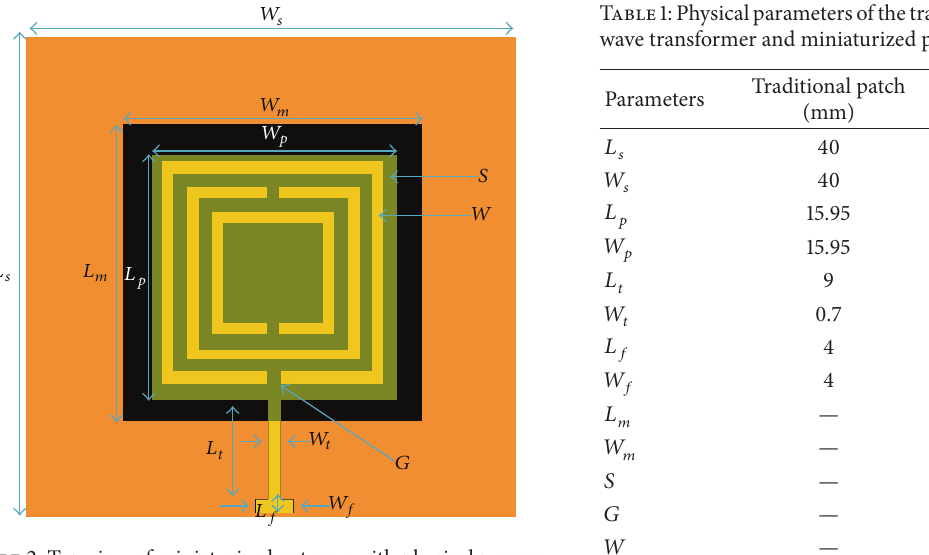
Figure 2: Top view of miniaturized antenna with physical parame- ters.